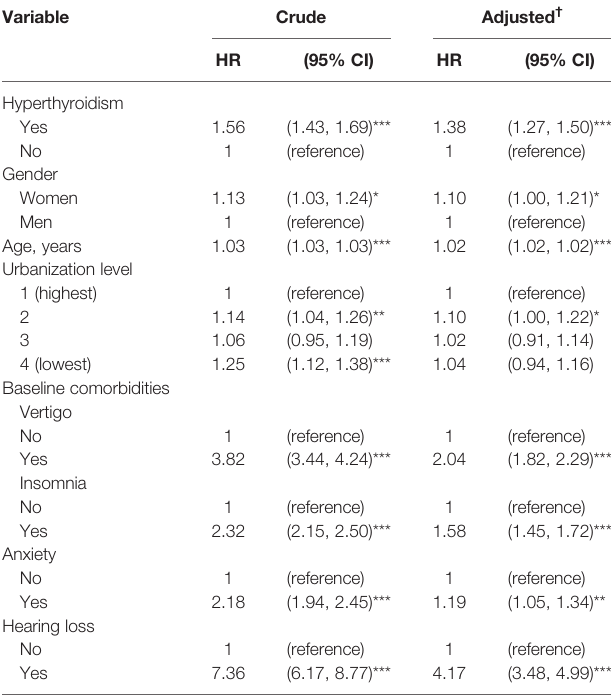
TABLE 3 | Associations between tinnitus, hyperthyroidism and covariates: Cox model with hazard ratios and 95% con fi dence intervals. Variable